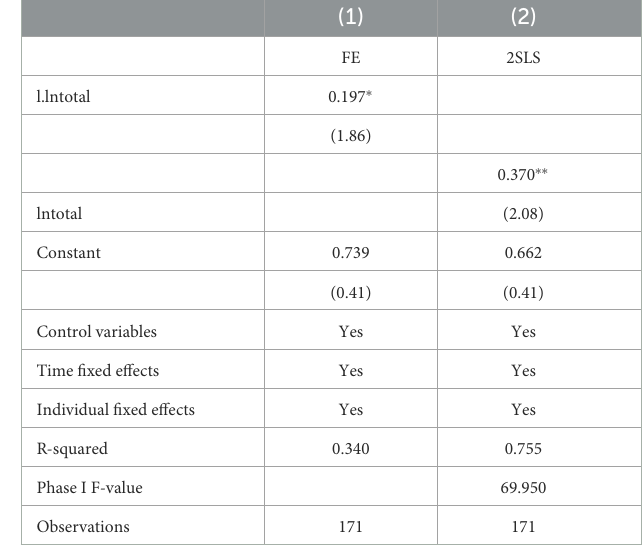
TABLE 6 Endogeneity test.